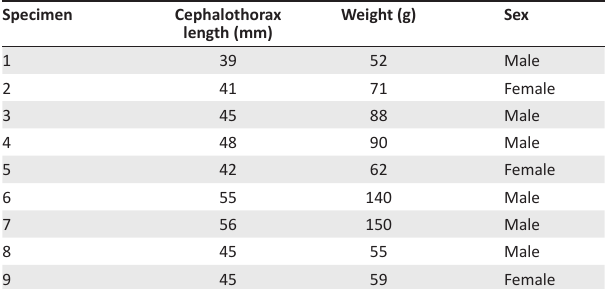
TABLE 1: Record of measurements recorded for redclaw crayfish captured below Van Graan Dam, Crocodile River, on the border of the Kruger National Park. Specimen Cephalothorax length